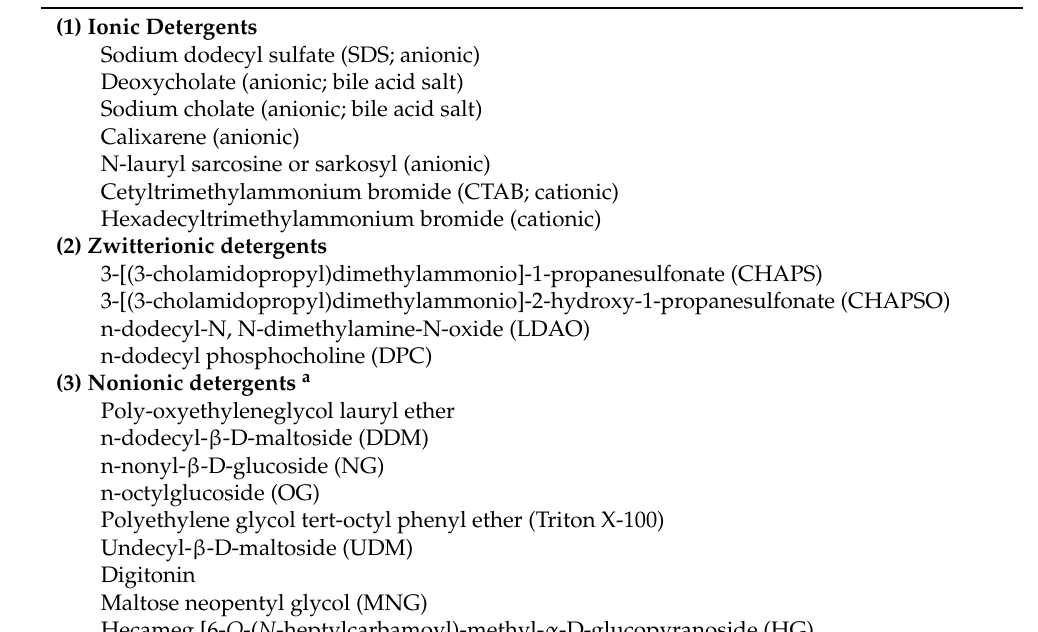
Table 1. A list of membrane solubilizing detergents commonly used for membrane protein